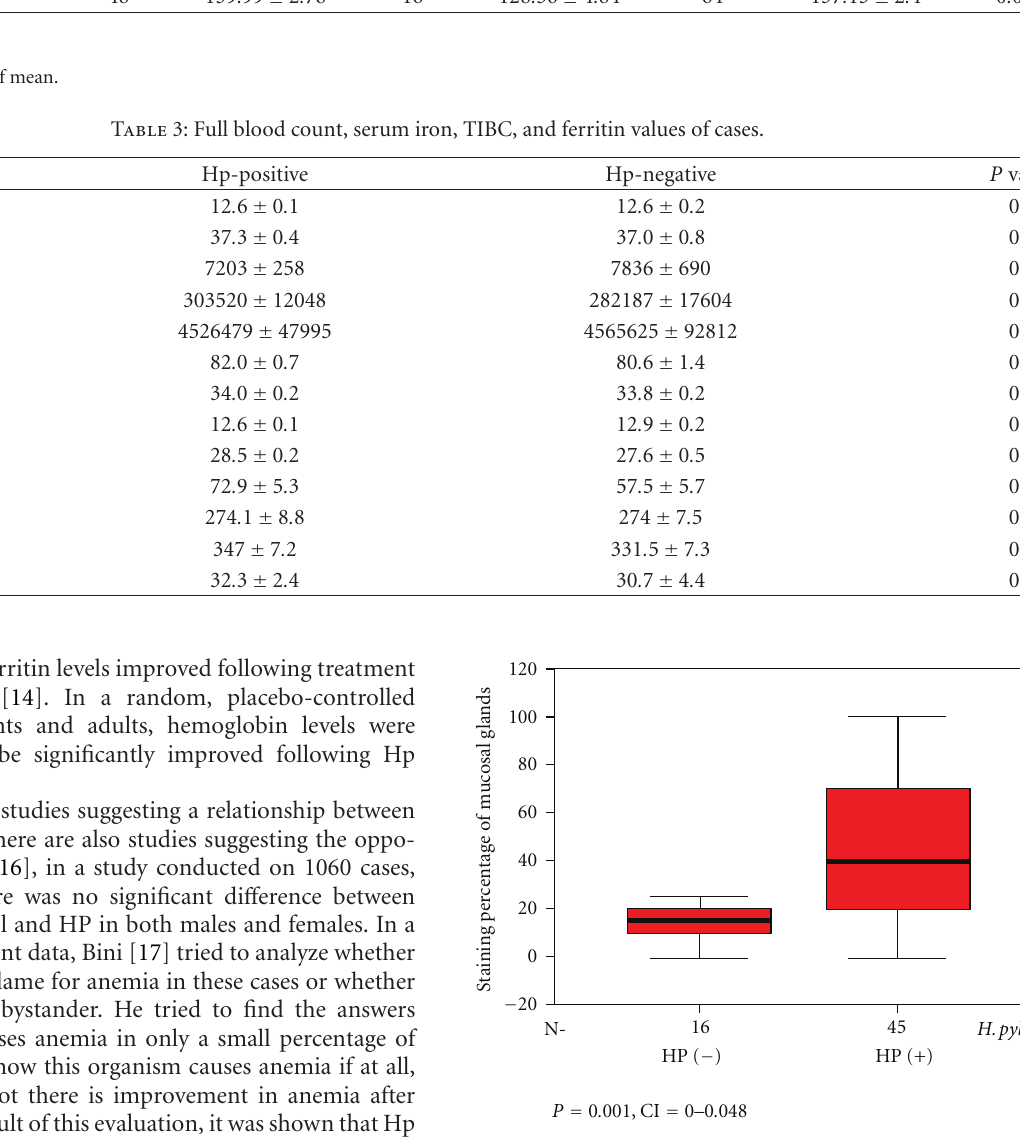
Figure 1: Staining percentage of antral mucosal glands by Hp- positive and -negative